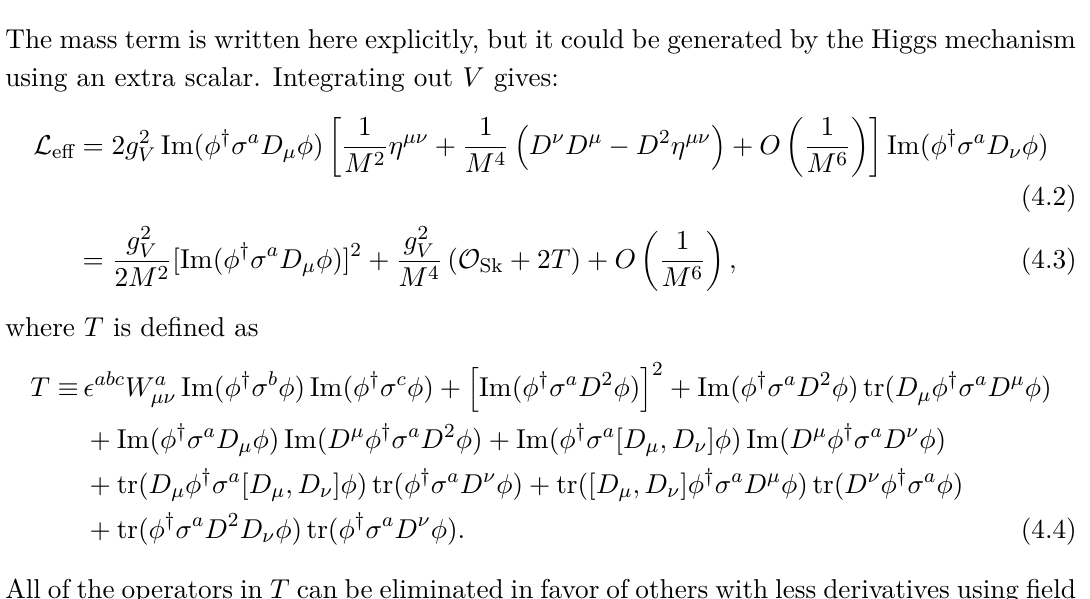
Figure 4 . Energy in natural E nat and physical E units, at n W = 1 , as a function of Λ for m h = 125 GeV and m h = 10 5 GeV